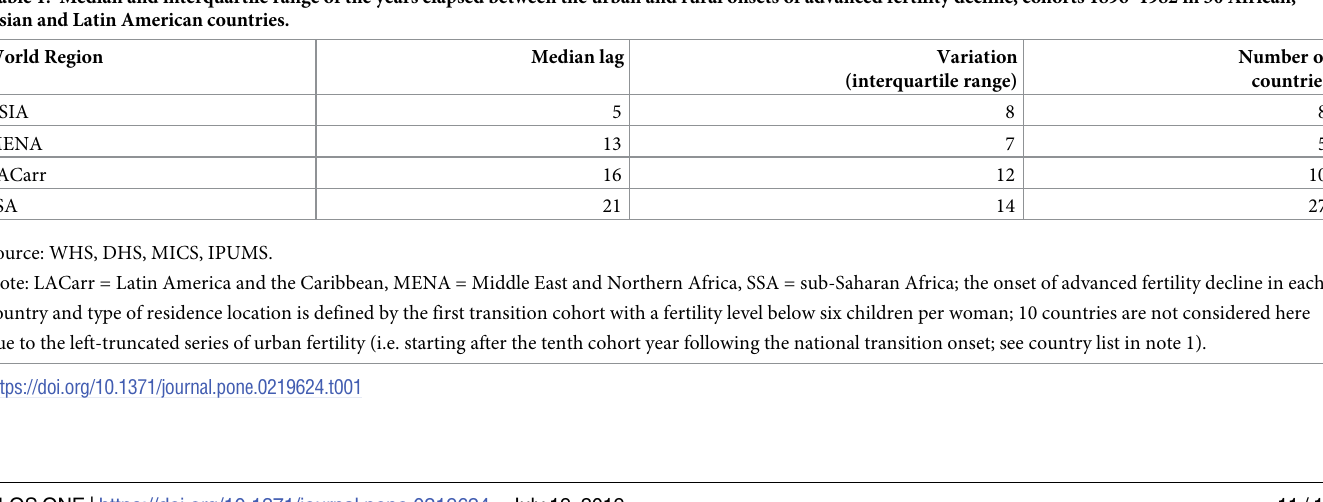
Table 1. Median and interquartile range of the years elapsed between the urban and rural onsets of advanced fertility decline, cohorts 1896–1982 in 50 African, Asian and Latin American countries. World Region Median lag Variation ASIA 5 8 8 MENA 13 7 5 LACarr 16 12 10 SSA 21 14 27 Source: WHS, DHS, MICS,